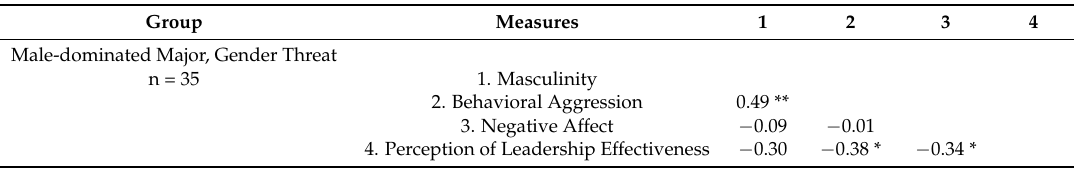
Table 2. Correlation table.